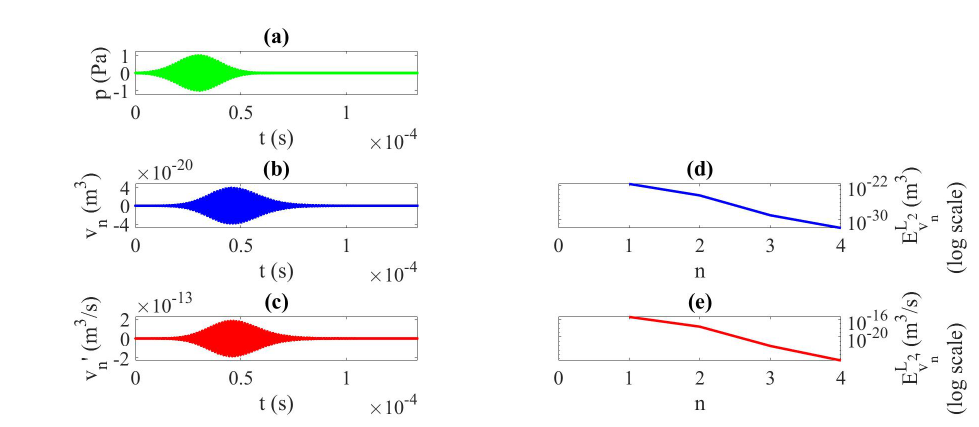
Figure 7. Case 3. f = f b , finite amplitude with nonlinear terms. ( a ) Pressure source signal, ( b ) bubble- volume variation, ( c ) speed of bubble-volume variation; last iteration n = N . L 2 -norm error at each iteration n of the calculation; ( d ) v n , ( e ) v (cid:48) n .